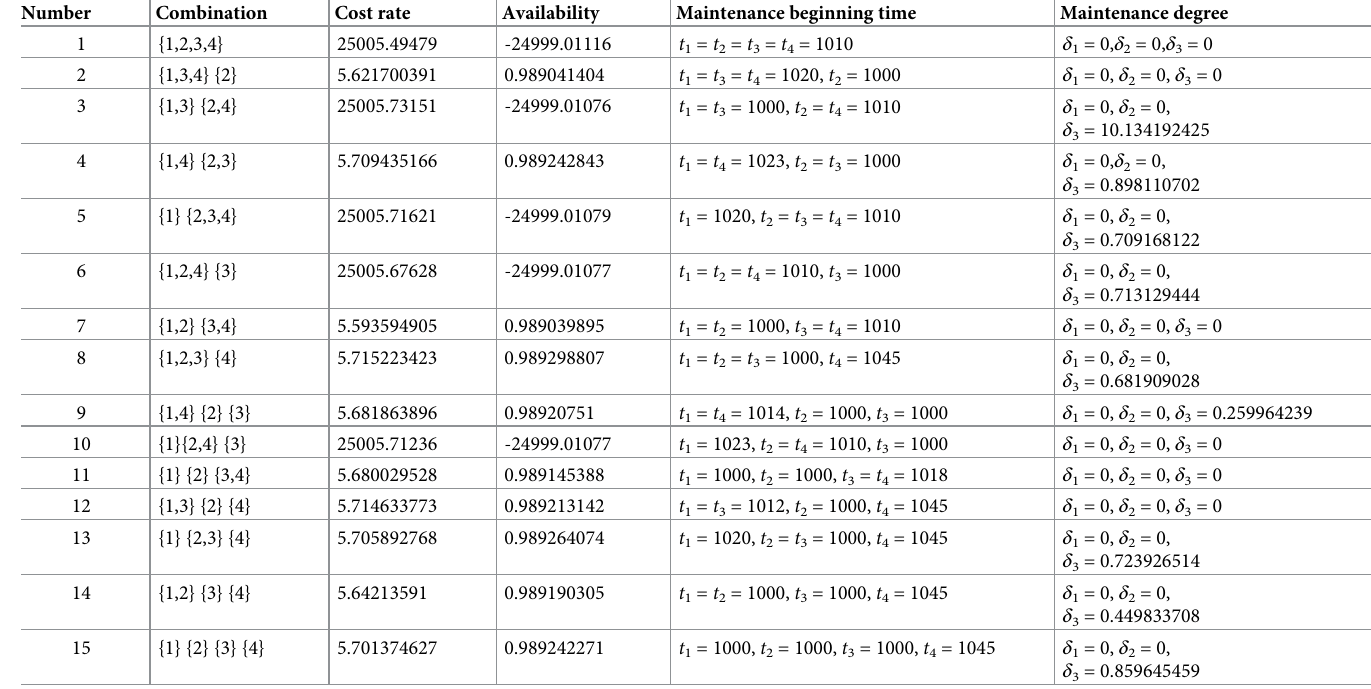
Table 3. Optimization results analysis when follow-up maintenance cost and downtime take the middle